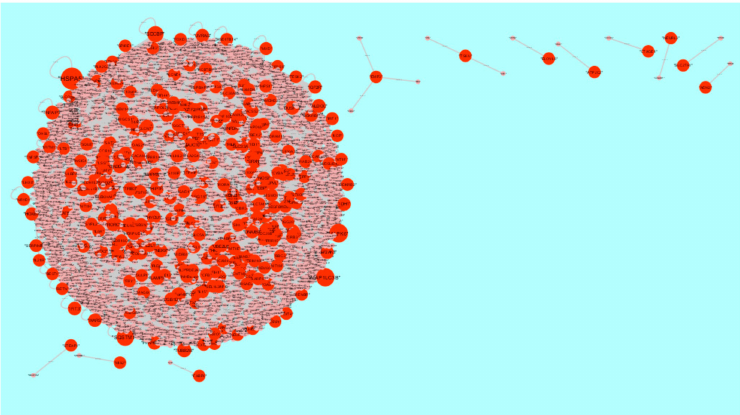
Figure 9. Protein-protein interaction network of di ff erentially expressed genes (DEGs). Orange nodes denote down-regulated genes.